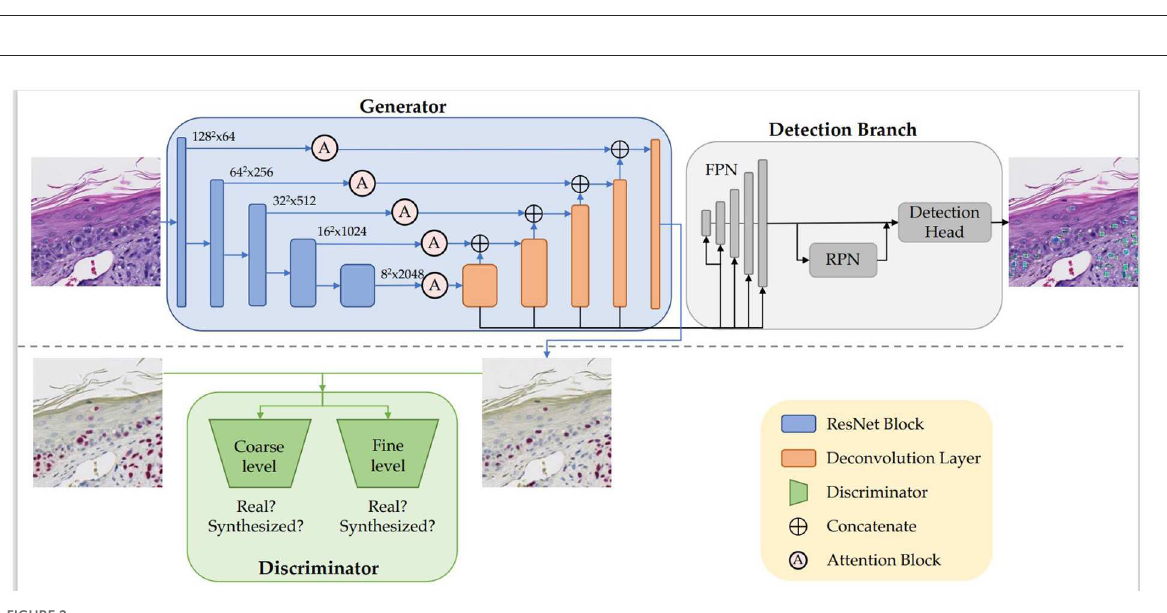
FIGURE2 Our VSGD-Net framework: H&E images are virtually stained to SOX10. The jointly trained detection branch utilizes the intermediate features in the generator to detect melanocytes and provides feedback to the generator to enhance synthesis quality. The inference phase only uses the upper part of the architecture (This figure appears in a manuscript submitted to WACV